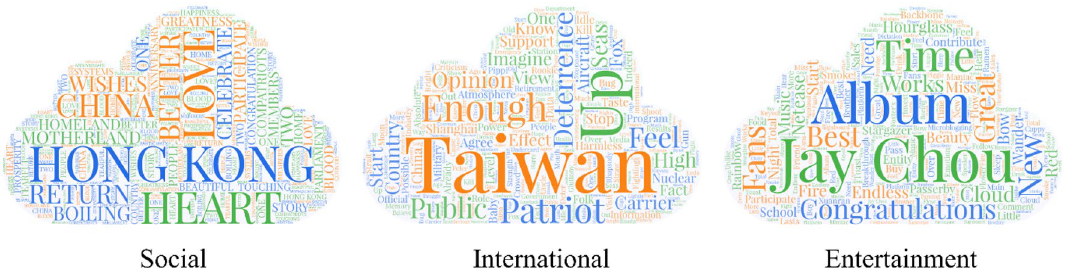
Figure 2. Keyword clouds for the three topics. We maintained the top 30 short videos with the largest number of comments under each topic as the set of events. Each topic corresponded to an interactive network formed by the commenting users of the 30 original short videos. The figure shows 3 topic keyword word clouds, and the size of the words is determined by the word frequency.